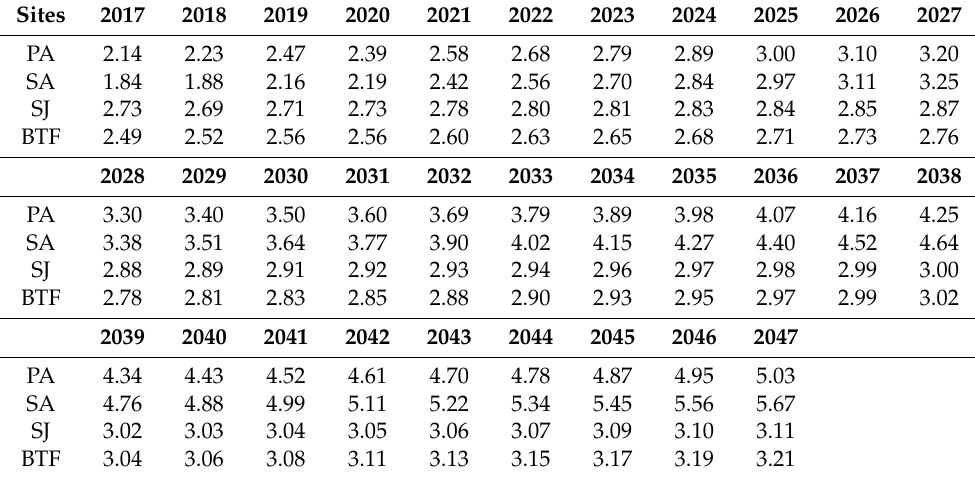
Table A1. Model projections (2017–2047) of soil carbon mass (kgC m − 2 yr − 1 ) at 25 cm depth at the four experimental sites in Ganghwa province of